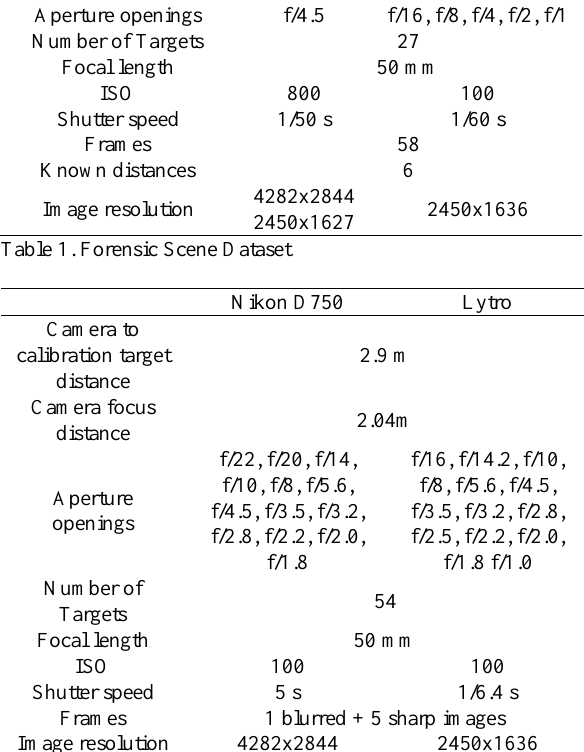
Table 2. Camera Calibration